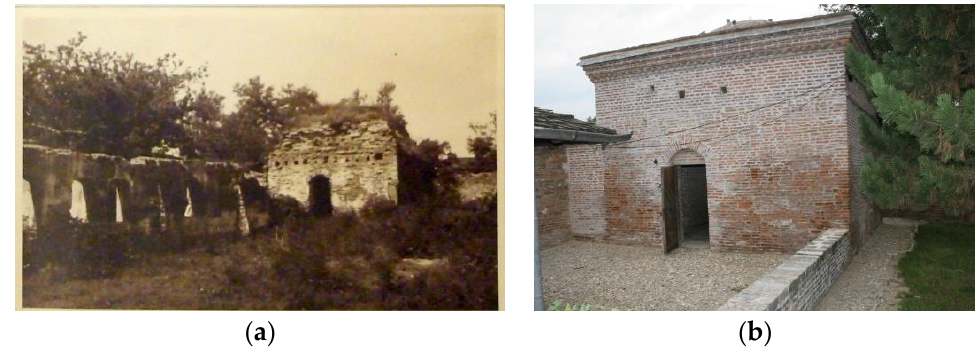
Figure 1. The outbuildings featuring the Turkish bath in 1942 ( a ) and at present time ( b